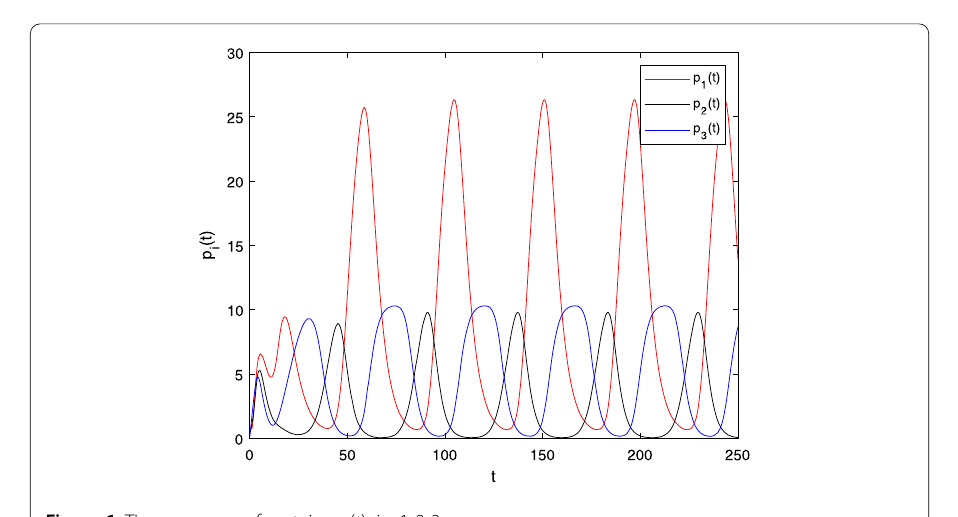
Figure 6 Time response of proteins p i ( t ), i =